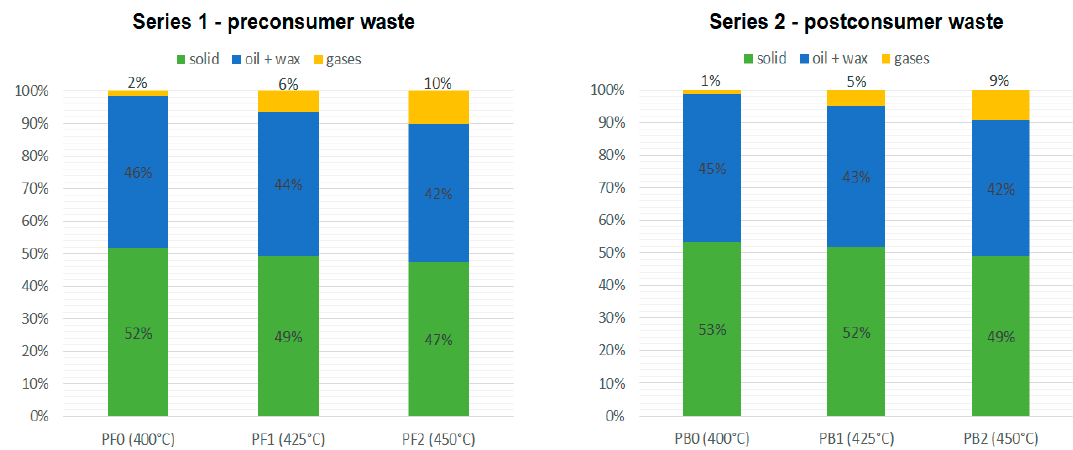
Figure 3. Masses of the products obtained during series 1 and 2.